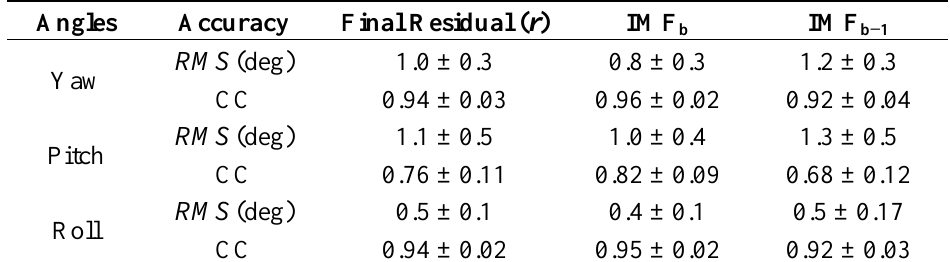
Table 1. Accuracy results obtained during treadmill walking. Final method outputs are in the IMF column. b